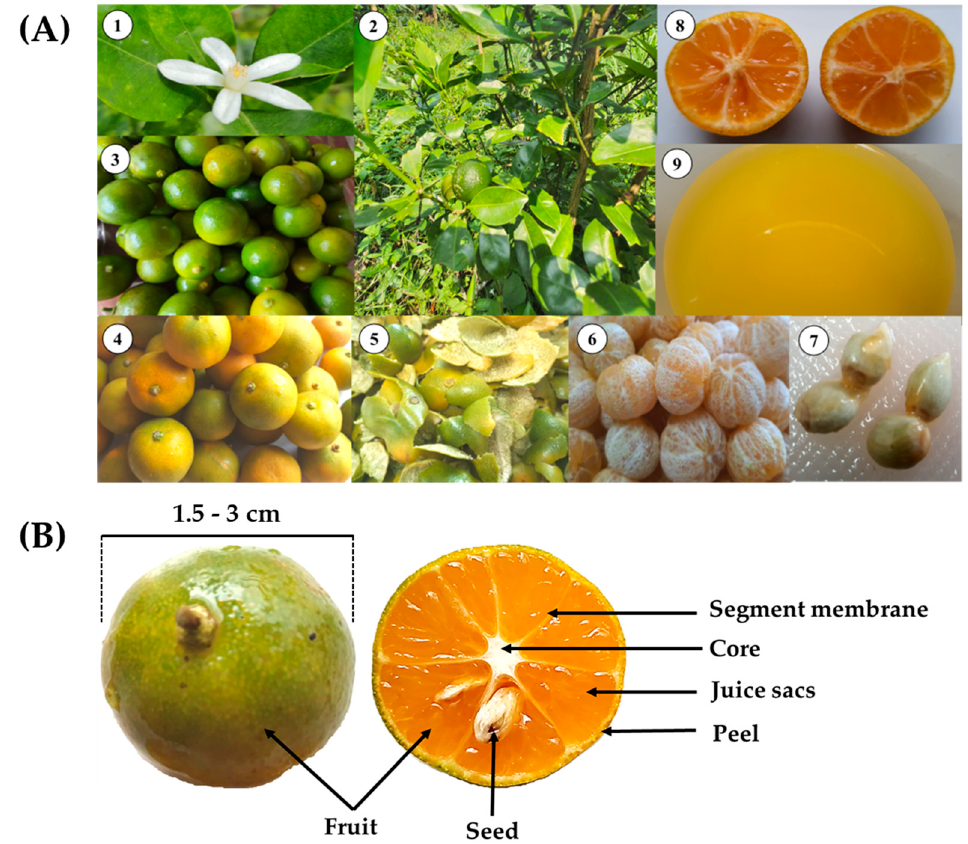
Figure 1. ( A ) General characteristics of calamondin: ( 1 ) flower, ( 2 ) stems and leaves, ( 3 ) unripe fruits, ( 4 ) ripe fruits, ( 5 ) peels, ( 6 ) peeled fruits, ( 7 ) seeds, ( 8 ) pulp, and ( 9 ) juice. ( B ) Calamondin fruit struc- ture.